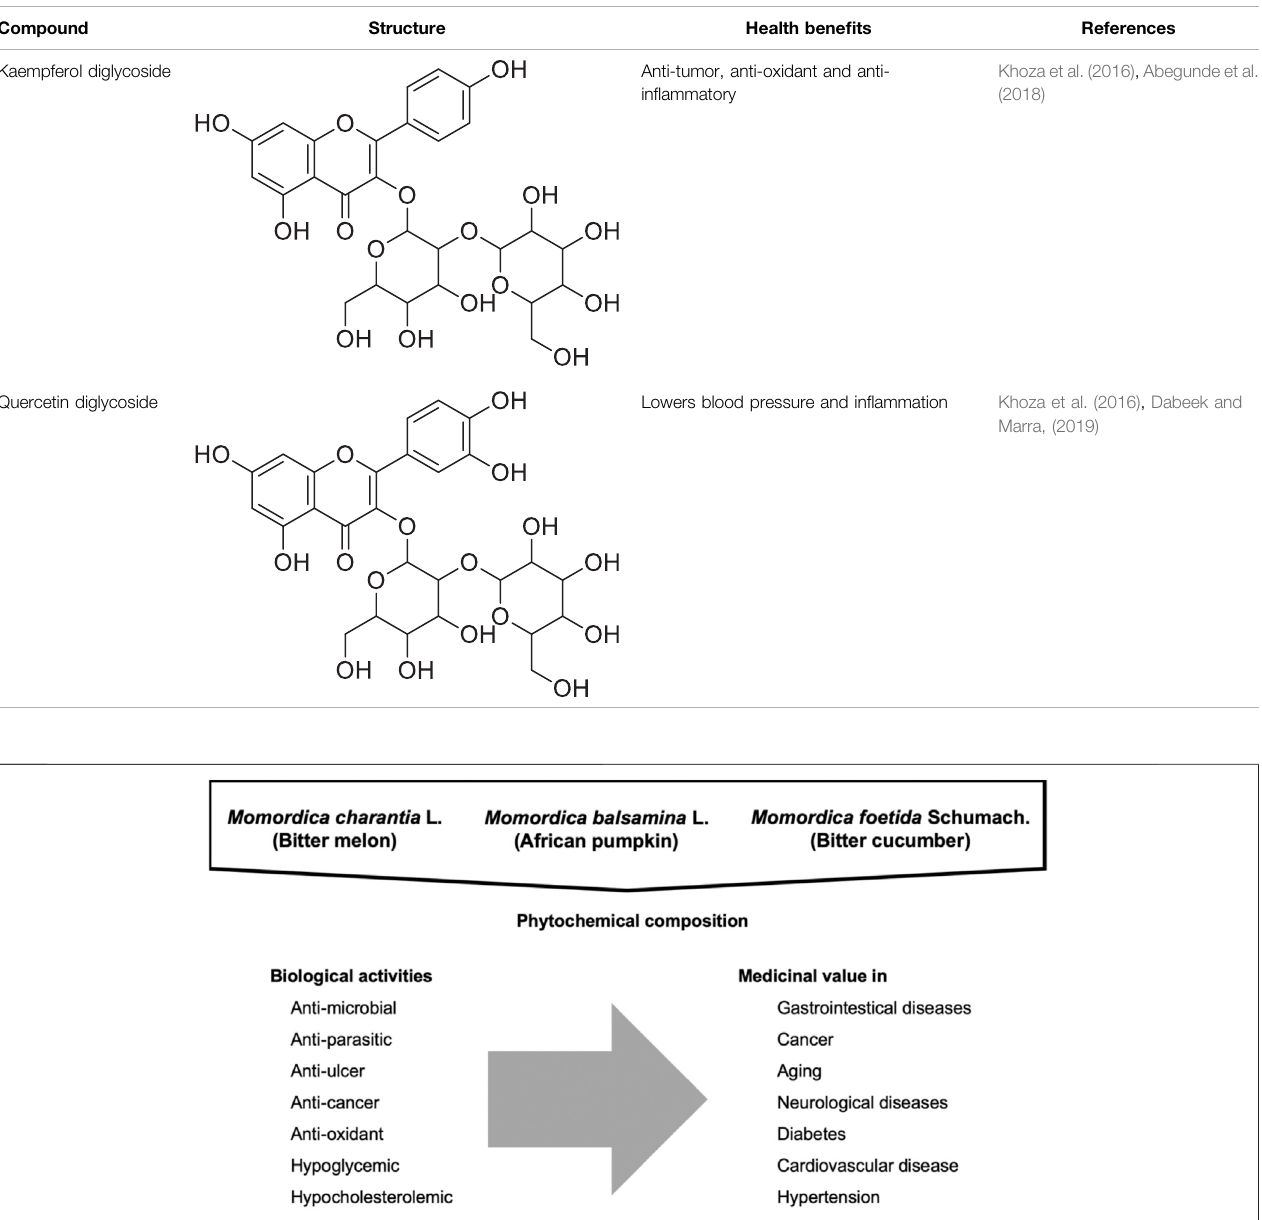
Frontiers in Pharmacology |